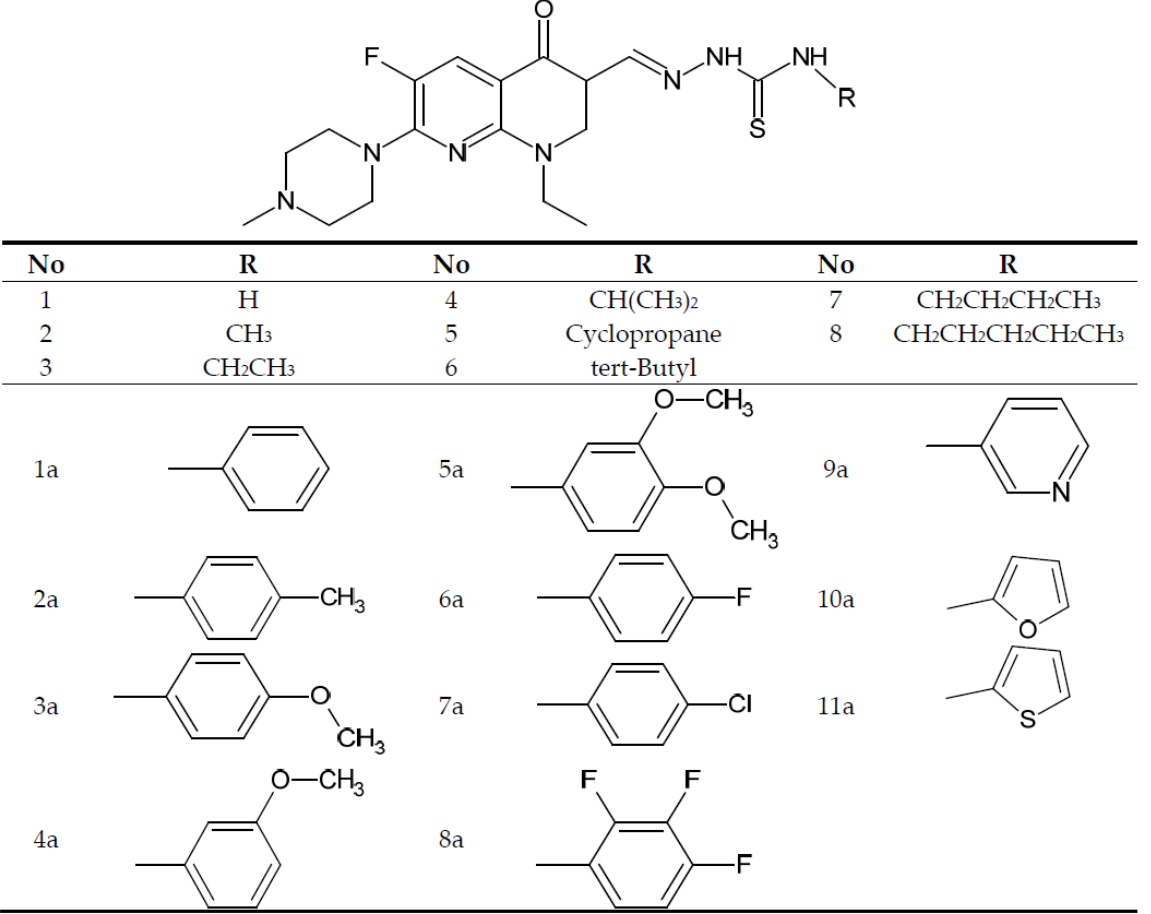
Figure 9. General structure of enoxacin alkyl (1–8) and aryl (1a–11a) derivatives prepared by Hu et al. [104] and Jiang et al. [105].